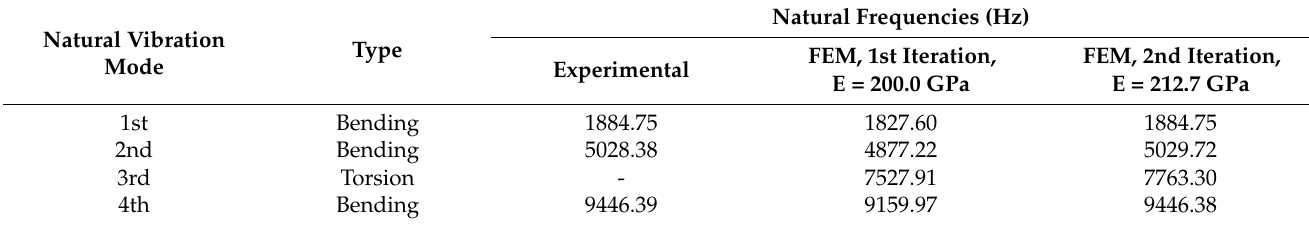
Table 3. Natural frequency and elasticity modulus.